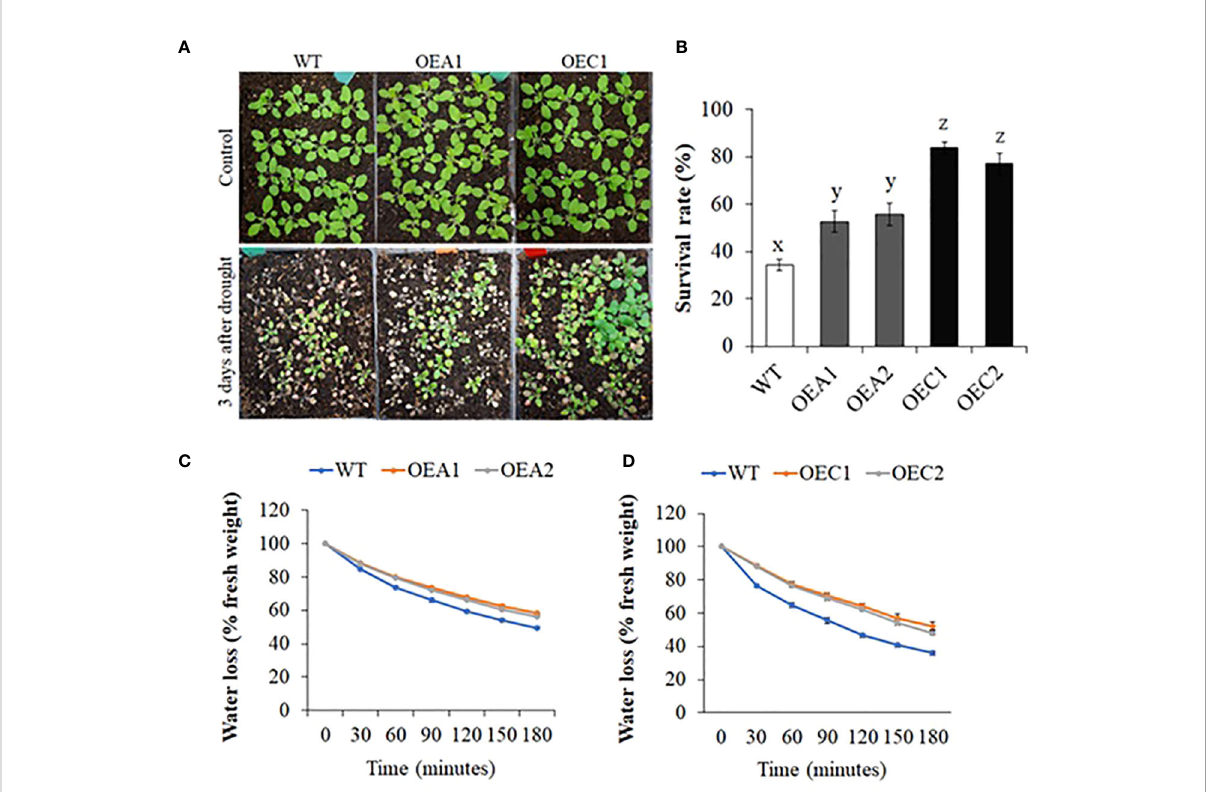
FIGURE 3 Drought survival and leaf water loss analysis in HD2 overexpression lines. (A) Images of WT and HD2-OE plants under control and two days after rewatering, following 13 days of drought stress. (B) Survival rates of WT, HD2A , and HD2C overexpression lines after drought stress. Data shown are means ± standard errors (n = 3) from three independent experiments. In each experiment, at least 30 plants of each genotype were used to calculate the survival. The signi fi cance of the differences between different genotypes was determined by one-way ANOVA followed by post- hoc Tukey ’ s HSD tests. Lowercase letters indicate signi fi cant differences (p < 0.01). (C, D) Fresh leaf water loss measured in HD2A-OE (C) and HD2C-OE (D) plants at every 30-minute interval for the period of 180 minutes. Data shown are means ± standard errors (n = 3) from three independent experiments. In each experiment, measurements were taken from three plants (three leaves per